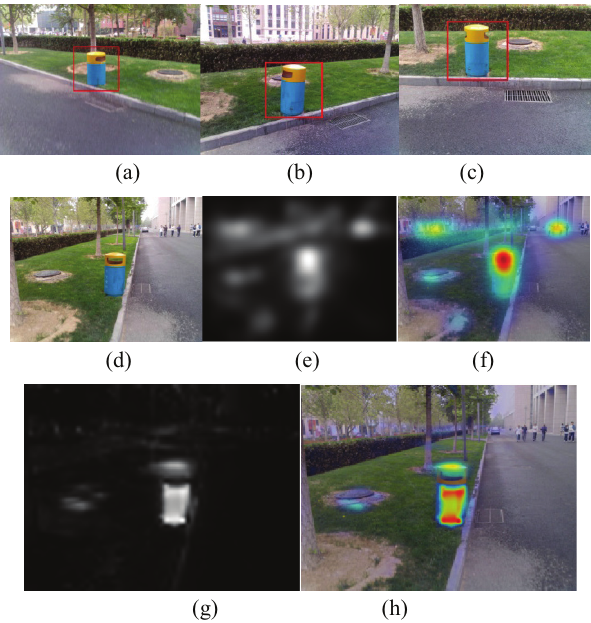
Fig. 6. Results of Experiment 3 where our target is a barrel (all images are taken in our campus): (a) Training image 1 (b) Training image 2 (c) Training image 3 (d) Test image (e) Itti’s saliency map (f) Itti’s saliency map represented as a heat map (g) our saliency map (h) our saliency map represented as a heat map